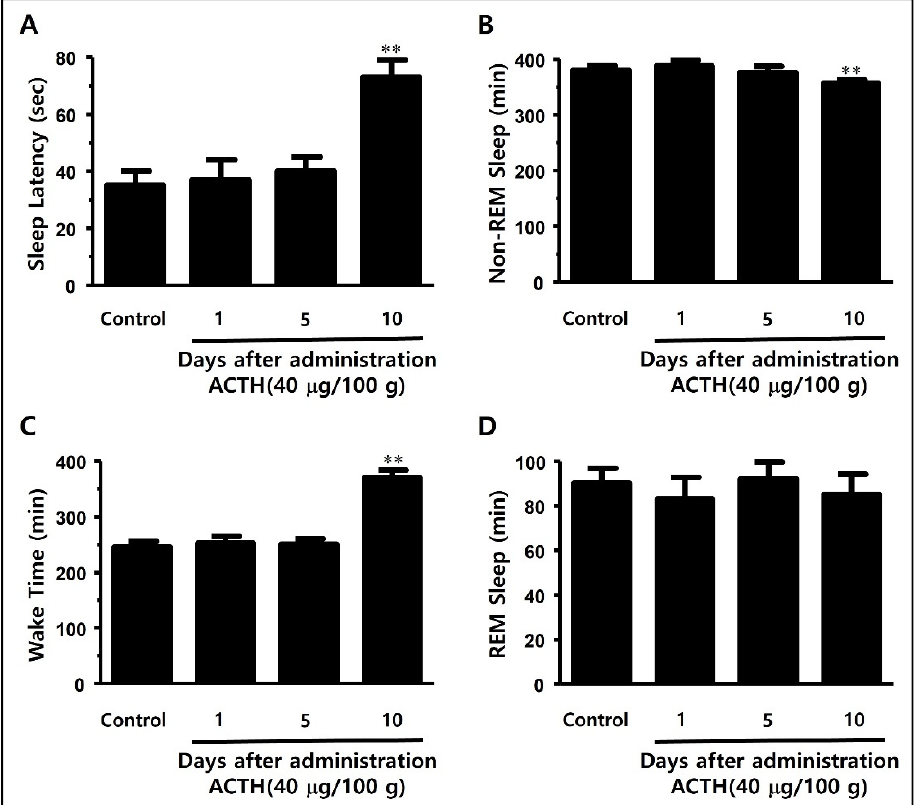
Figure 8. Changes in ( A ) waking time, ( B ) sleep latency, ( C ) non-REM sleep time, and ( D ) REM sleep time according to the days after ACTH injection in SD rat models. ( A ) Analysis of the change in waking time after 1, 5, and 10 days of ACTH injection shows a significant increase in waking time on day 10 compared to the control group. ( B ) Analysis of the change in sleep latency shows a significant increase in sleep latency on day 10 compared to the control group. ( C ) Analysis of the change in total non-REM sleep time shows a significant decrease in non-REM sleep time at day 10 compared to the control group. ( D ) The change in total REM sleep time shows no statistical significance. ACTH (400 μ g/kg) was intraperitoneally injected on days 1, 5, and 10. The data are shown as mean ± standard deviation. Each group consists of three mice. Statistical significance was evaluated based on the p -value, and significant differences from the control group are marked as ** p < 0.001.